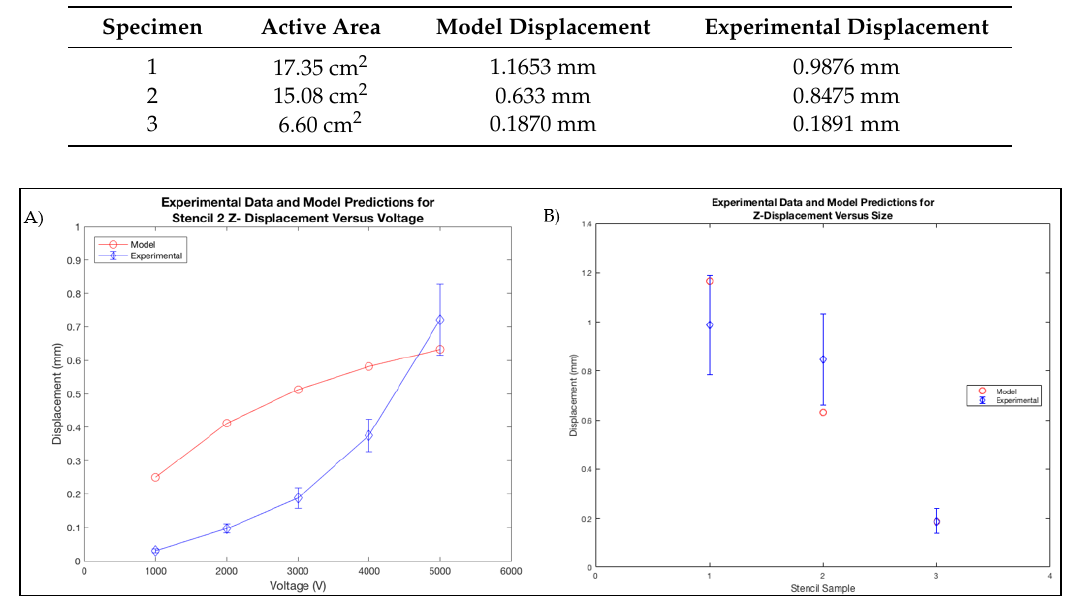
Figure 9. Experimental and Model Displacement Data versus Voltage. ( A ) Stencil 2 Voltage Response; ( B ) Actuation versus Size.